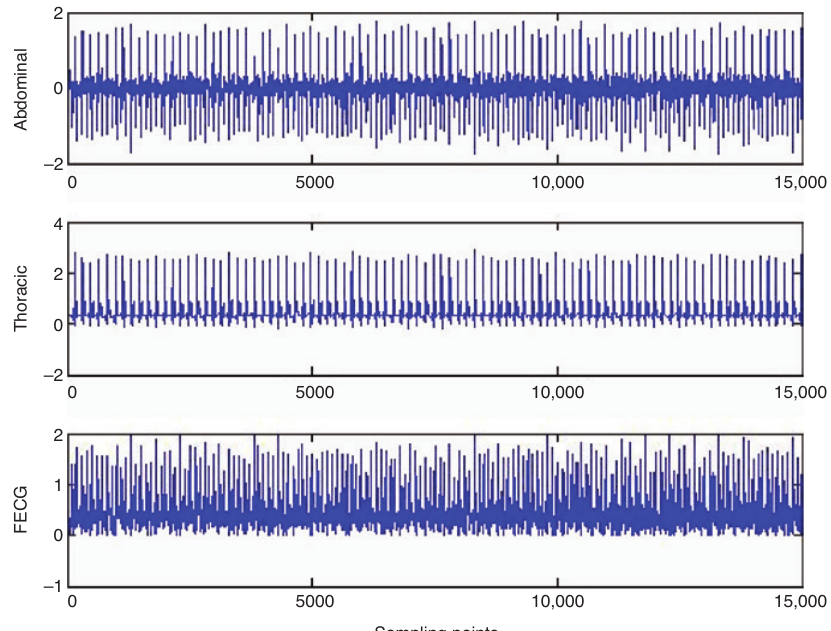
Figure 8: fECG Extraction for Sample Input 3.